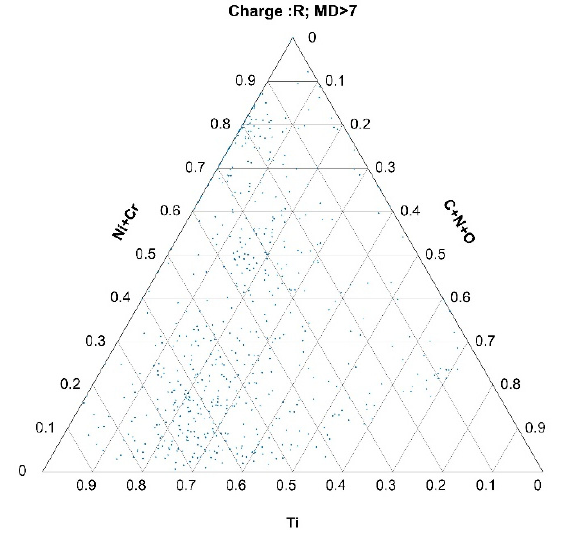
Figure 8. Inclusions classified as outlying (MD > 7) represented in a ternary diagram of Ti, C+N+O, and Ni+Cr for charges A, B, and R.